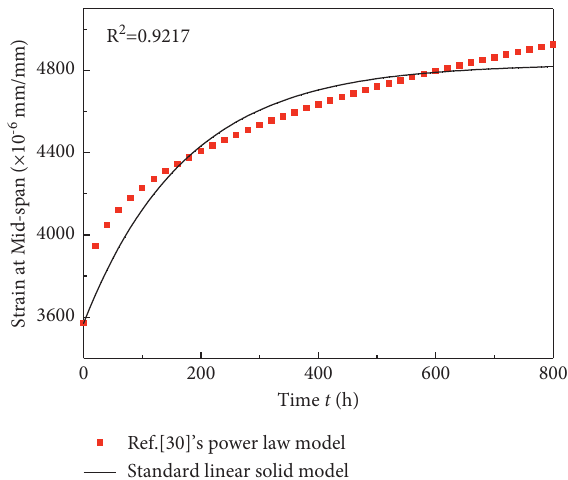
Figure 4: The fitting curve of the standard linear solid constitutive model.